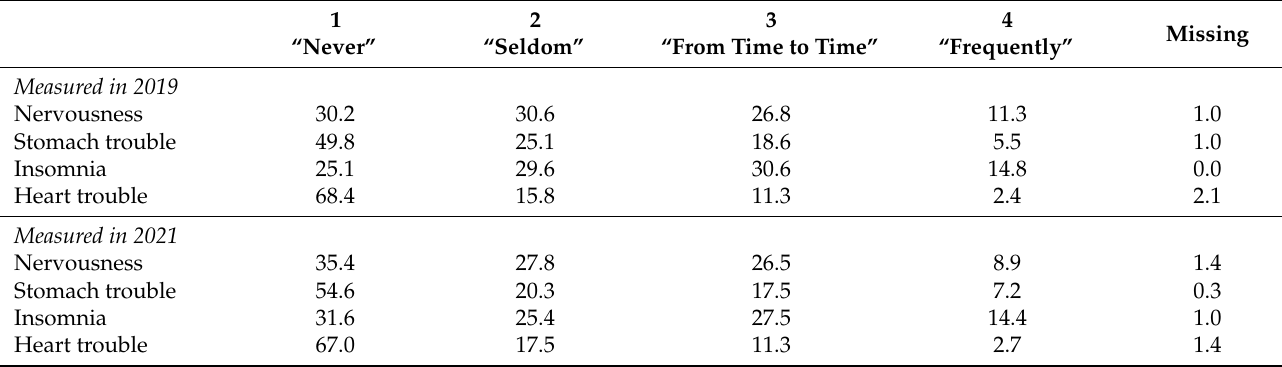
Table A4. Distribution of items for measuring G-Score in percent, N =